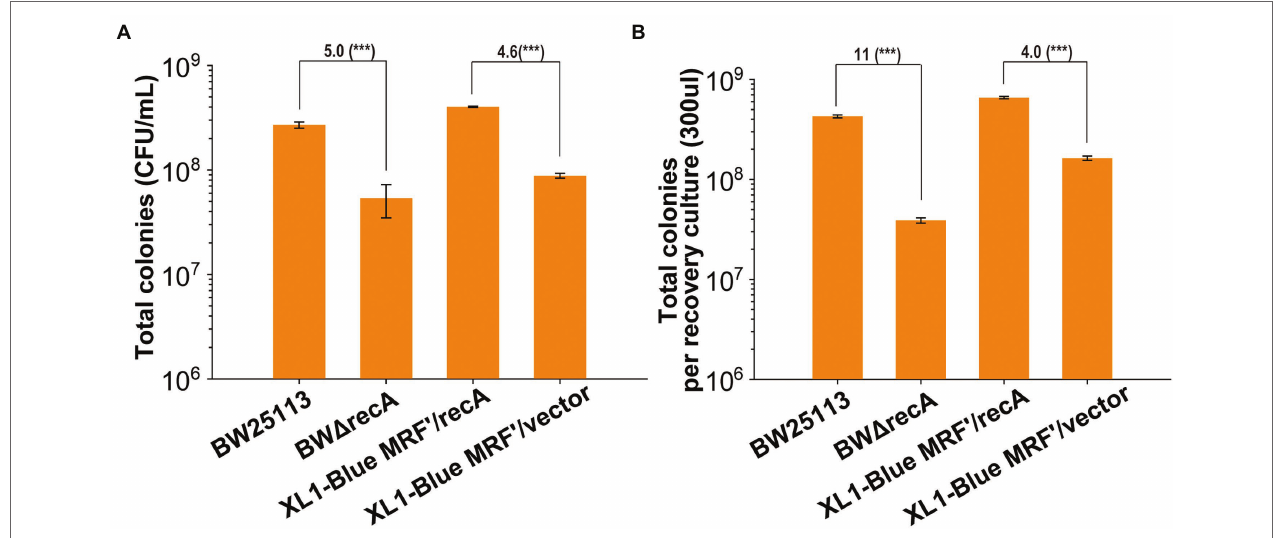
FIGURE 3 | The changes of recovered total colonies for four strains before competent cells preparation and after transformation. (A) Total colonies of recA mutants and their parent wild-type strains formed on LB plates without antibiotics after they were cultured until their OD 600nm reached at 0.5. (B) Total colonies of recA mutants and their parent wild-type strains formed on LB plates without antibiotics after recovering in LB medium for 60 min. Unpaired t-tests were performed (*** = p < 0.001). The numbers before (***) represent the difference by folds. Data are averages of three samples with standard deviations (error bars).